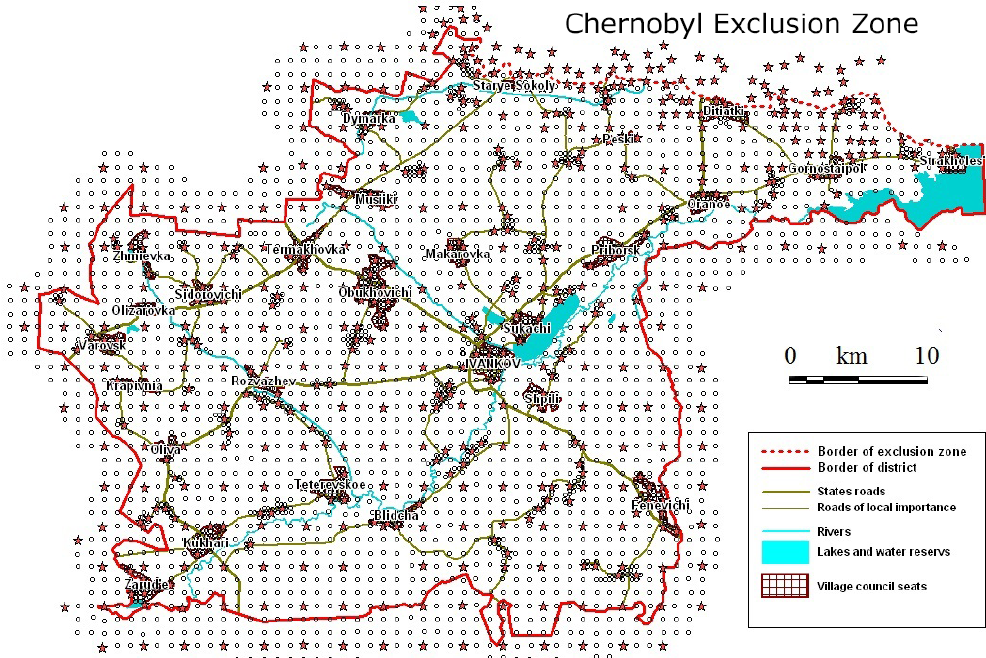
Figure 3. Map of the soil sampling locations in the Ivankov district which borders the CEZ: soil sampling and gamma survey (red stars); gamma survey only (grey